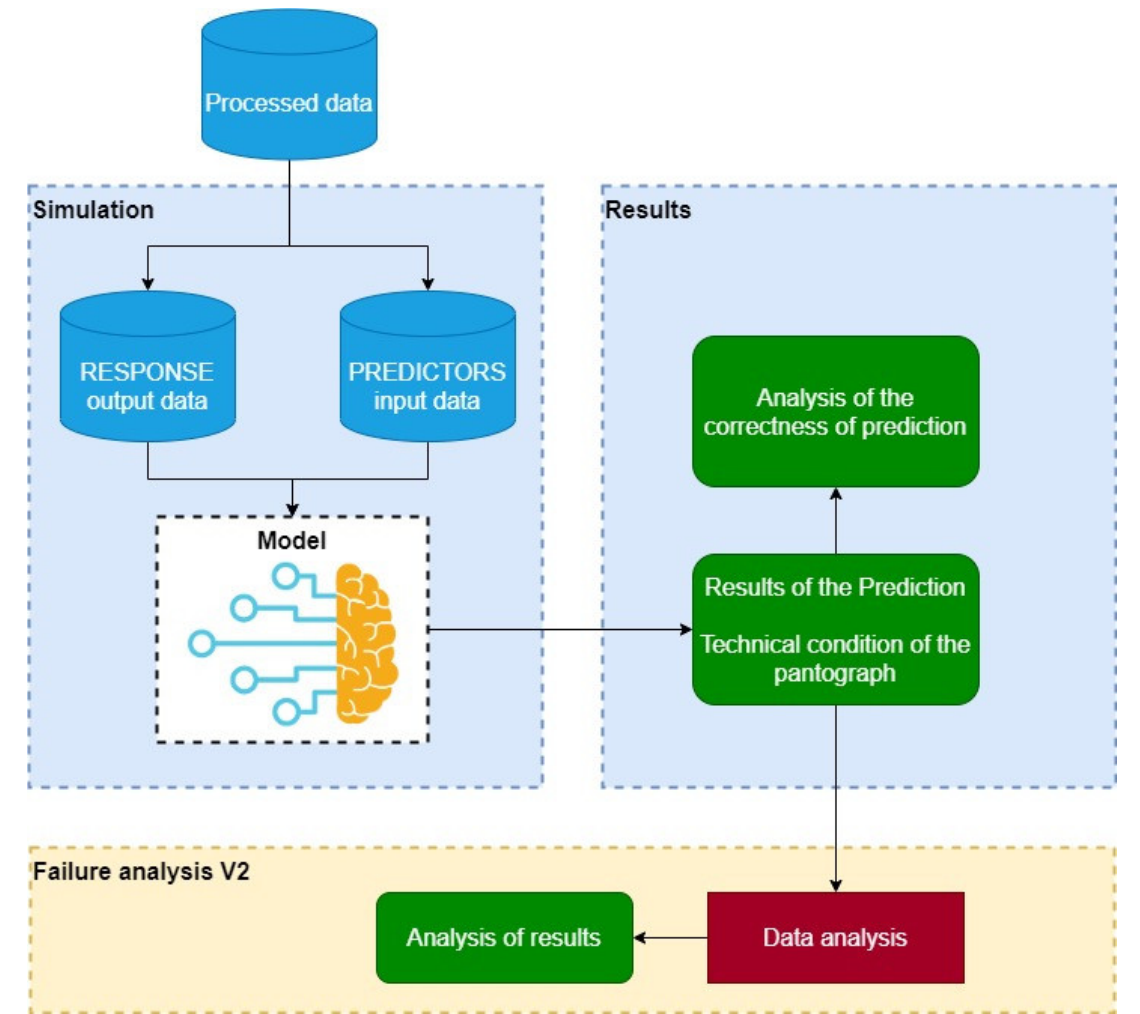
Figure 4. Method of three-valued prediction of technical condition based on machine learning and failure analysis for variant I—step II.